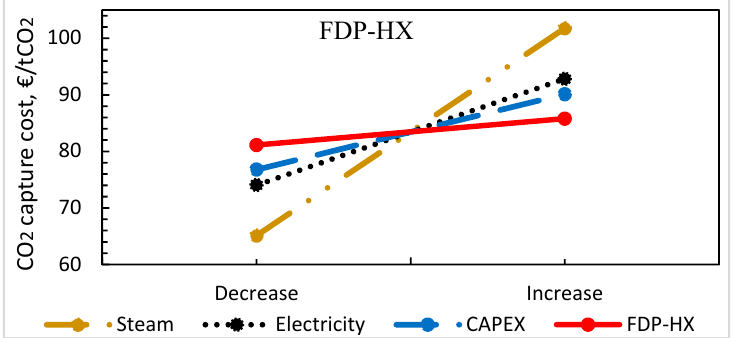
Figure 12. Sensitivity of important economic variables on the capture cost of the FDP-HX case.